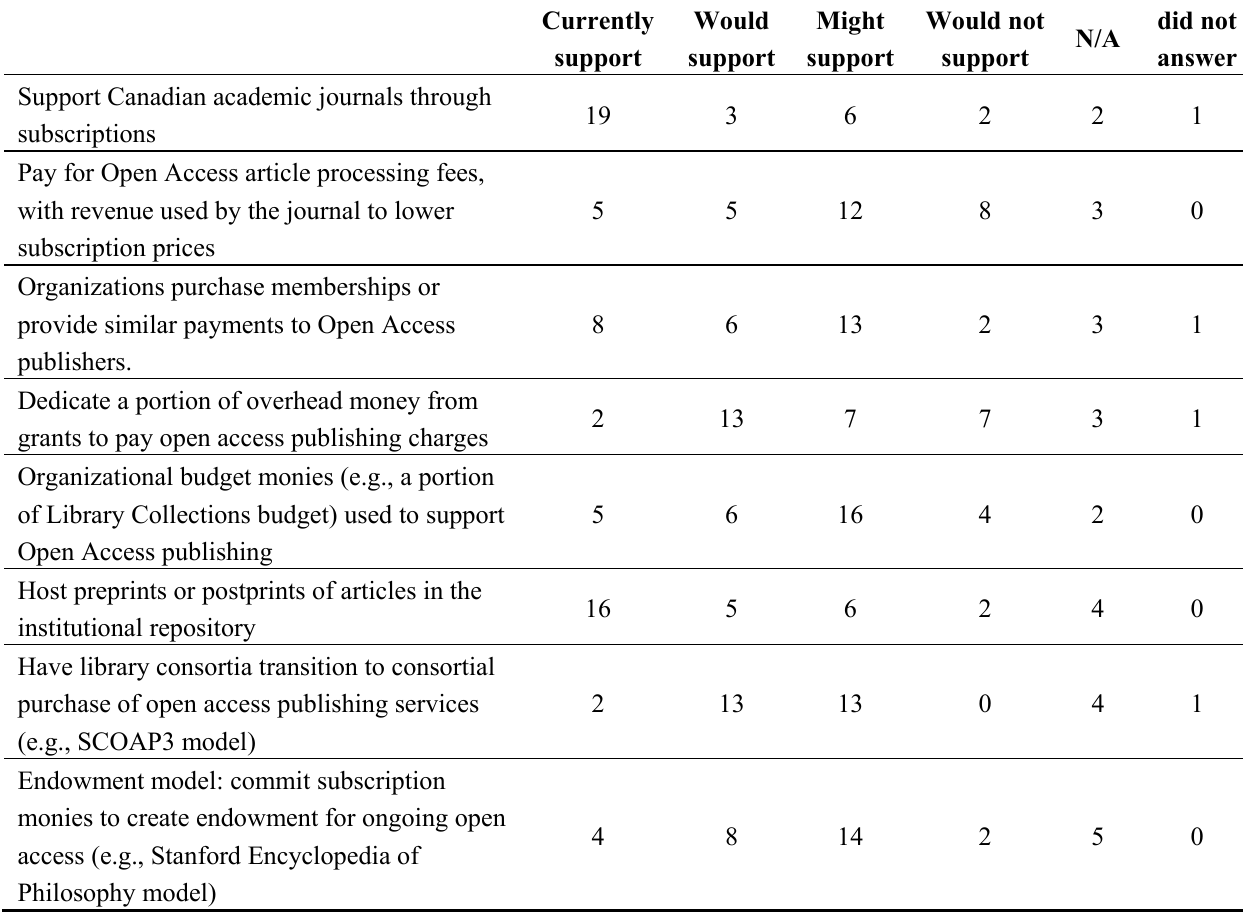
Table 1. Level of internal support for